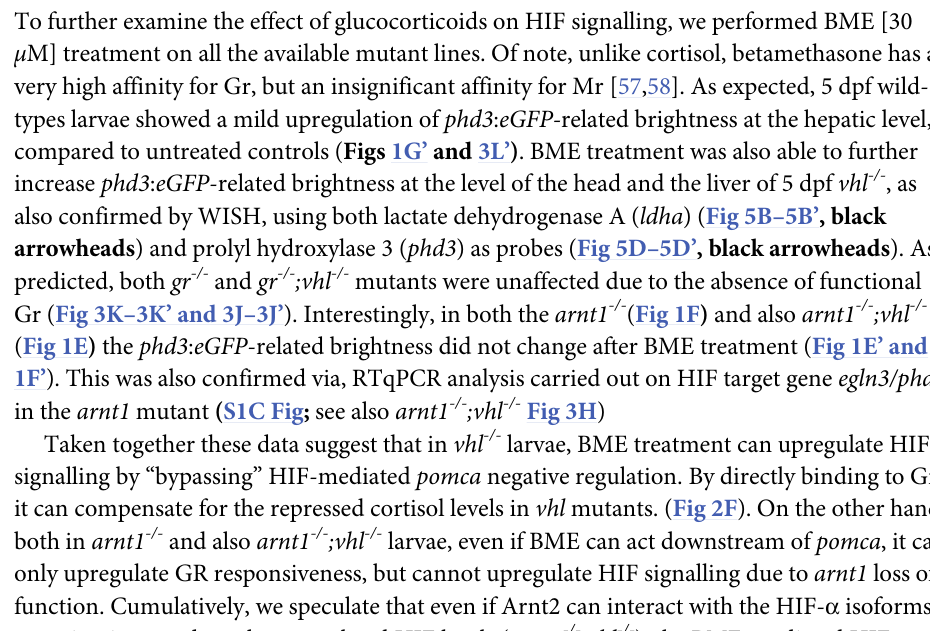
( Fig 1E) the phd3 : eGFP -related brightness did not change after BME treatment ( Fig 1E’ and